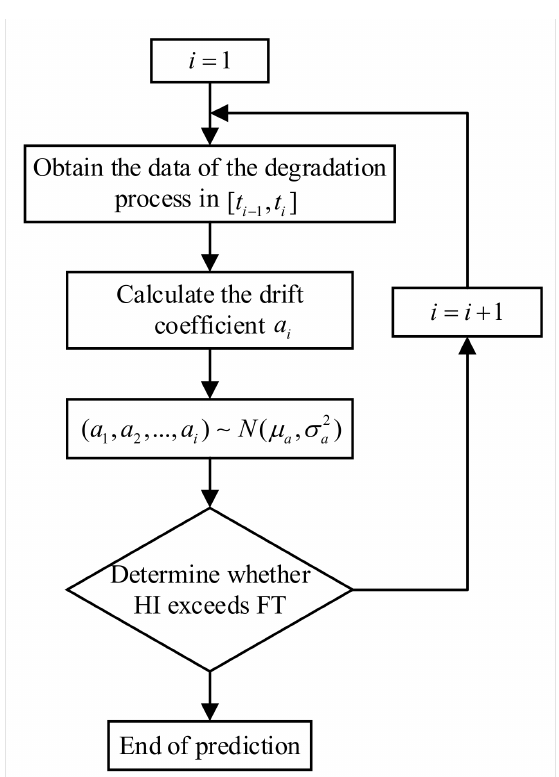
Figure 5. Adaptive update of the drift